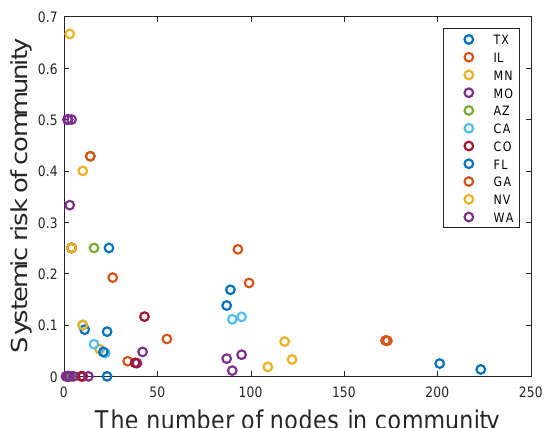
Figure 10. Relationship between systemic risk and the number of nodes in the community when the resolution parameter is 0.8.